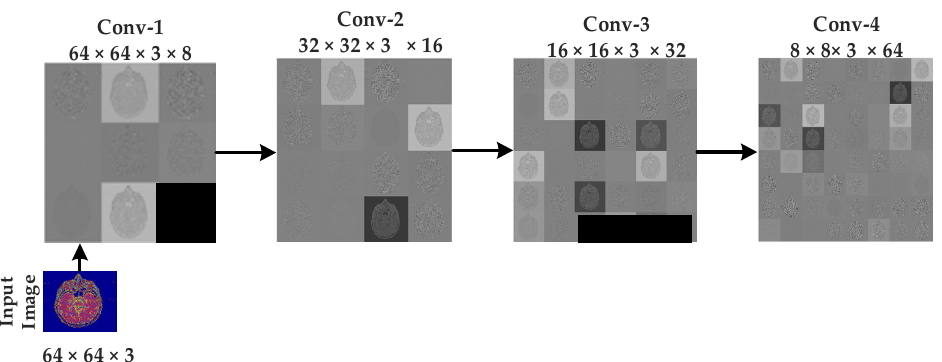
Figure 8. Intermediate results of sequences at CNN.